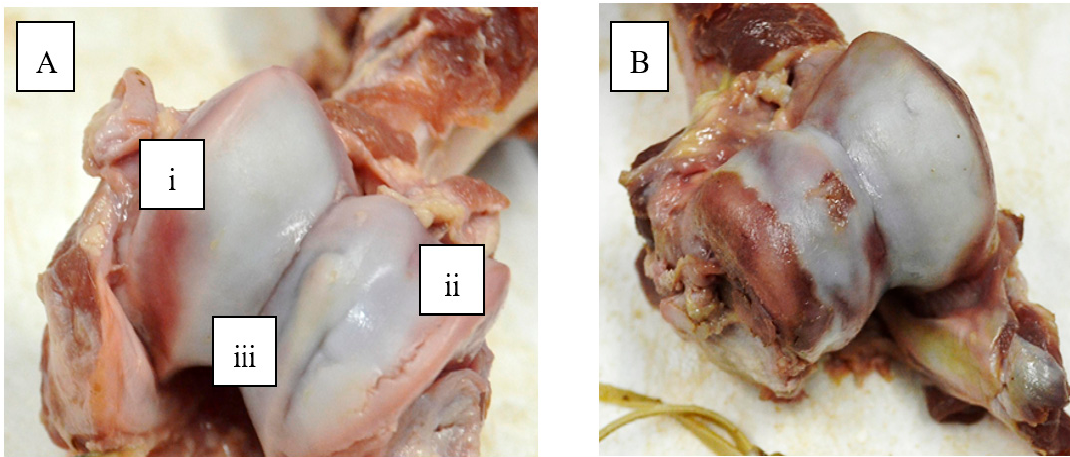
Figure 1. A ) (i) Thinning of cartilage, as evidenced by red bruise-like area (ii) Invagination of